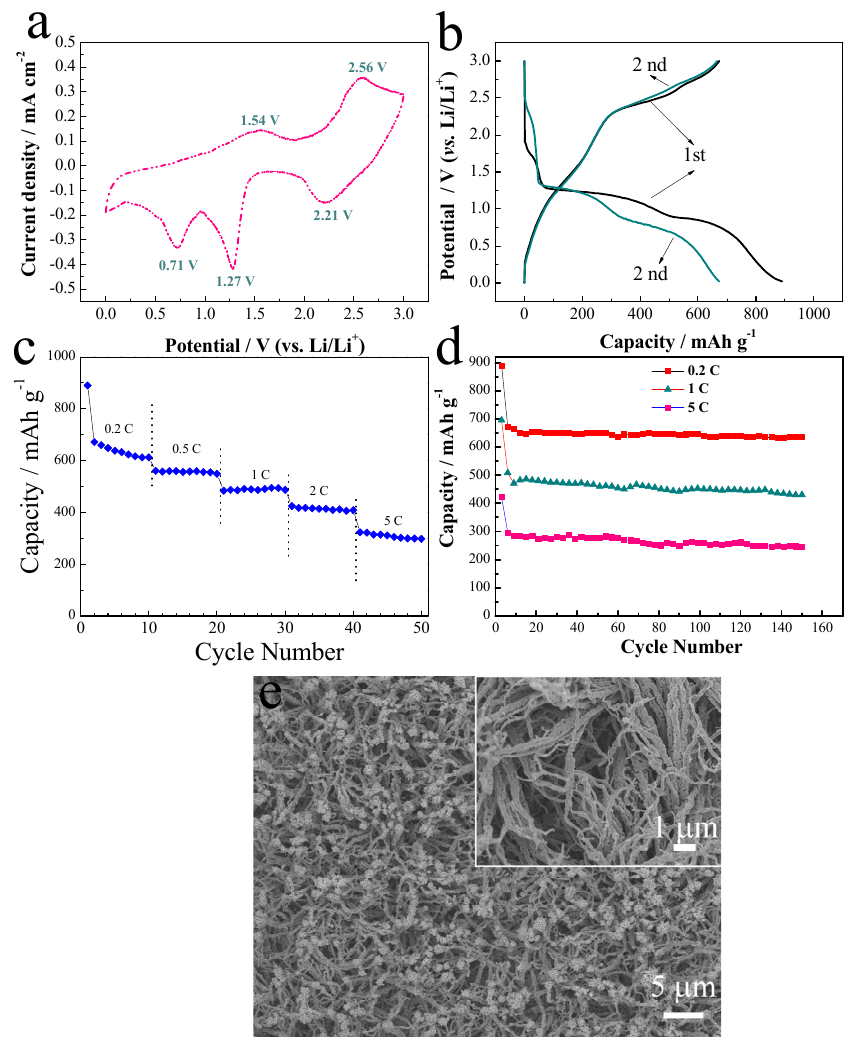
Figure 3. Electrochemical characterizations of CuO/C core/shell nanowires as anode of lithium ion batteries (LIBs). ( a ) Cyclic voltammetry (CV) curve at a scan of 0.1 V·s − 1 at the second cycle; ( b ) First charge/discharge profiles at 0.2 C; ( c ) Rate capability; ( d ) Cycling life at different rates; ( e ) SEM morphology after 150 cycles at 0.2